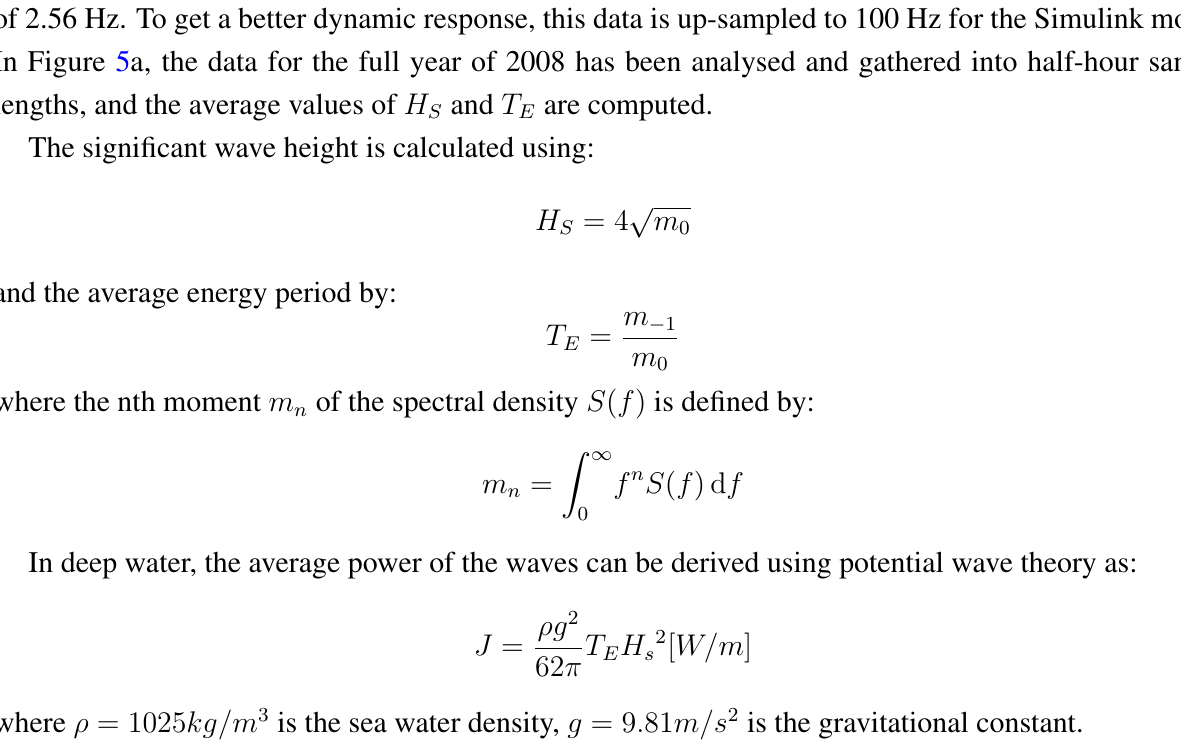
Measurement cabin